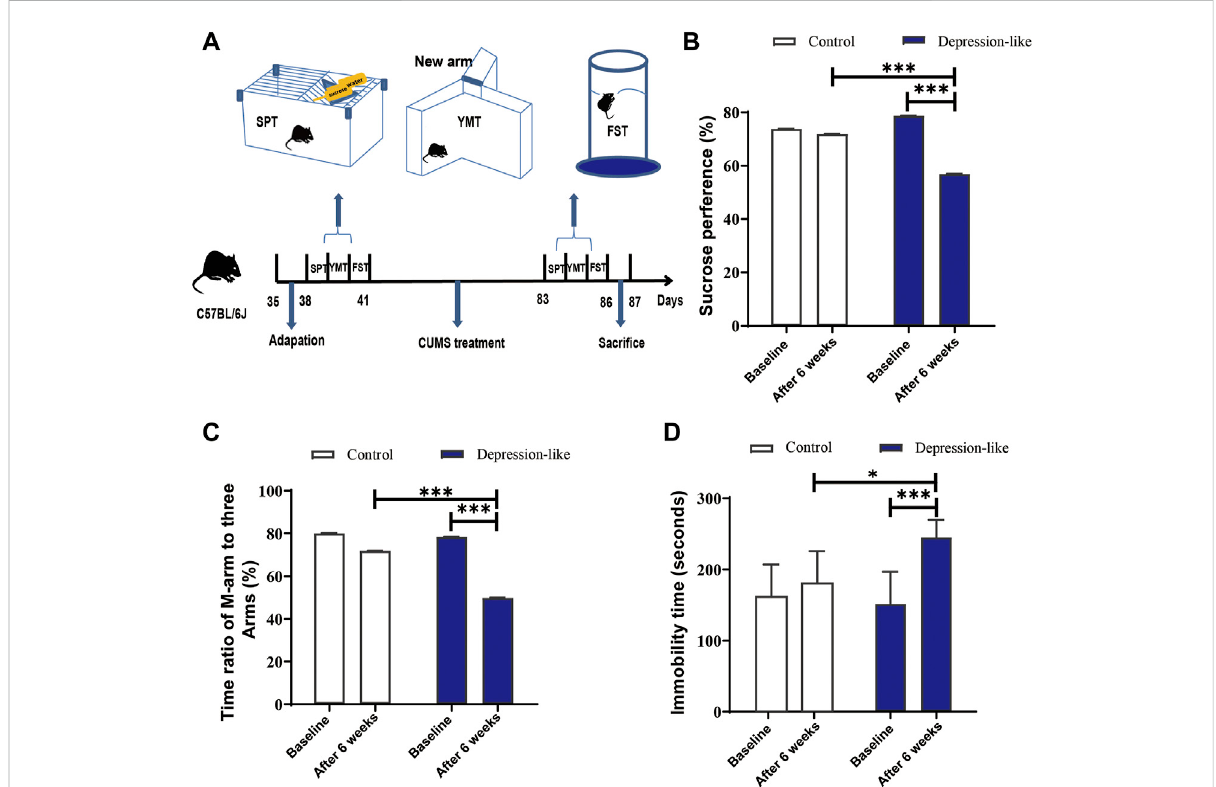
FIGURE 1 CUMS treatment leads mice to express depression-like behaviors. (A) Diagram of the production of depression-like mice. The procedure includesadaptationforaweek,CUMStreatmentfor6 weeks,behavioraltests,andde fi nition. (B) SPTvalues(%)ofthecontrolandCUMSmicebefore andaftertreatment. (C) TimeratiosoftheM-armtothreearmsbeforeandaftertreatmentsincontrolandCUMSmice. (D) Immobiletimeofstayingin thewatercylinderbeforeandaftertreatmentsincontrolandCUMSmice.Thepaired t -testwasconductedforthecomparisonsbeforeandafter the CUMS treatment (*** p < 0.001, ** p < 0.01, and * p < 0.05). Control ( n = 9) and depression-like ( n = 14) mice were used to conduct this